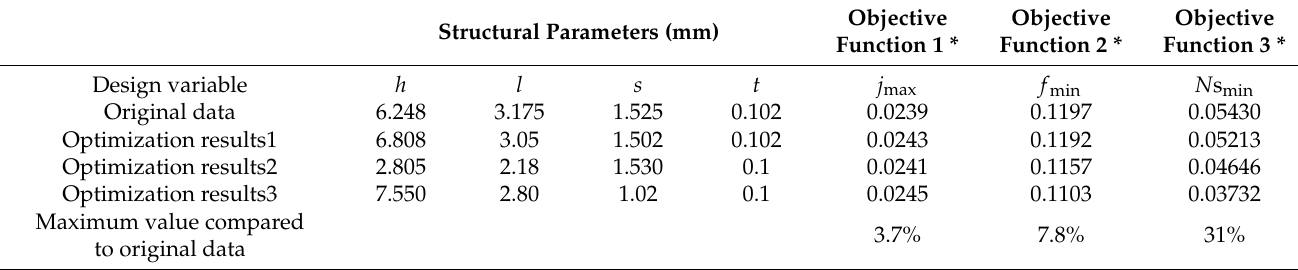
Table 3. Comparison of optimization results under objective function.